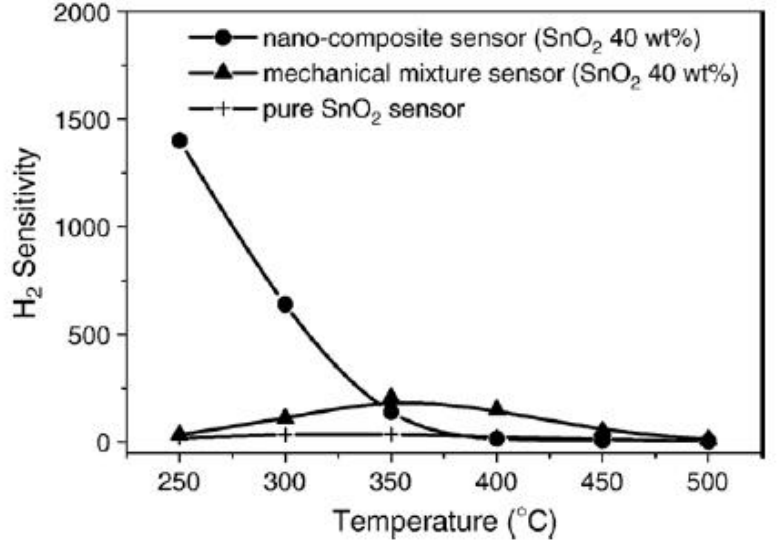
Figure 11. Correlation between sensing temperature and sensitivity to 1,000 ppm H different types of SnO gas sensors (adapted from 2